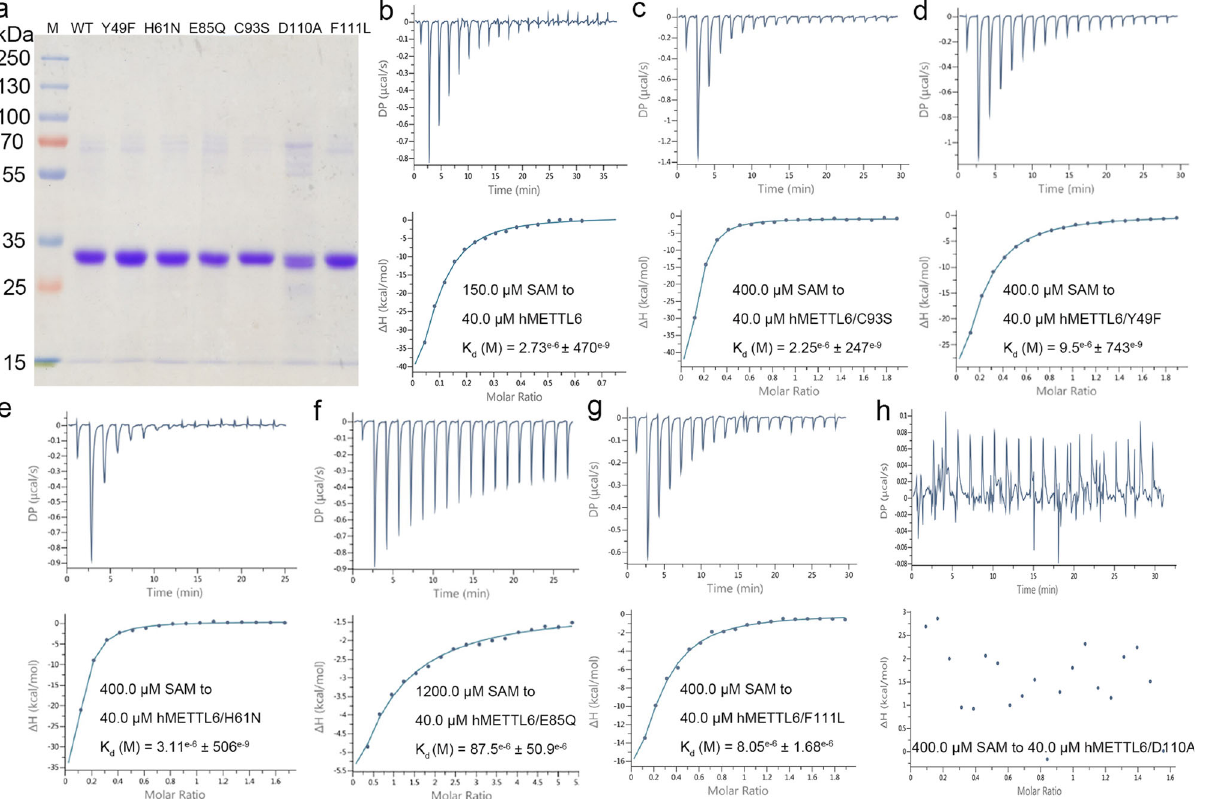
Fig. 3 The ITC titration of hMETTL6 WT and mutants by SAM. a The purity assessment of the hMETTL6 WT and mutants by SDS-PAGE gel electrophoresis. b − h The titration curves of hMETTL6 WT and mutants by SAM. The fi nal K D values were given for all the